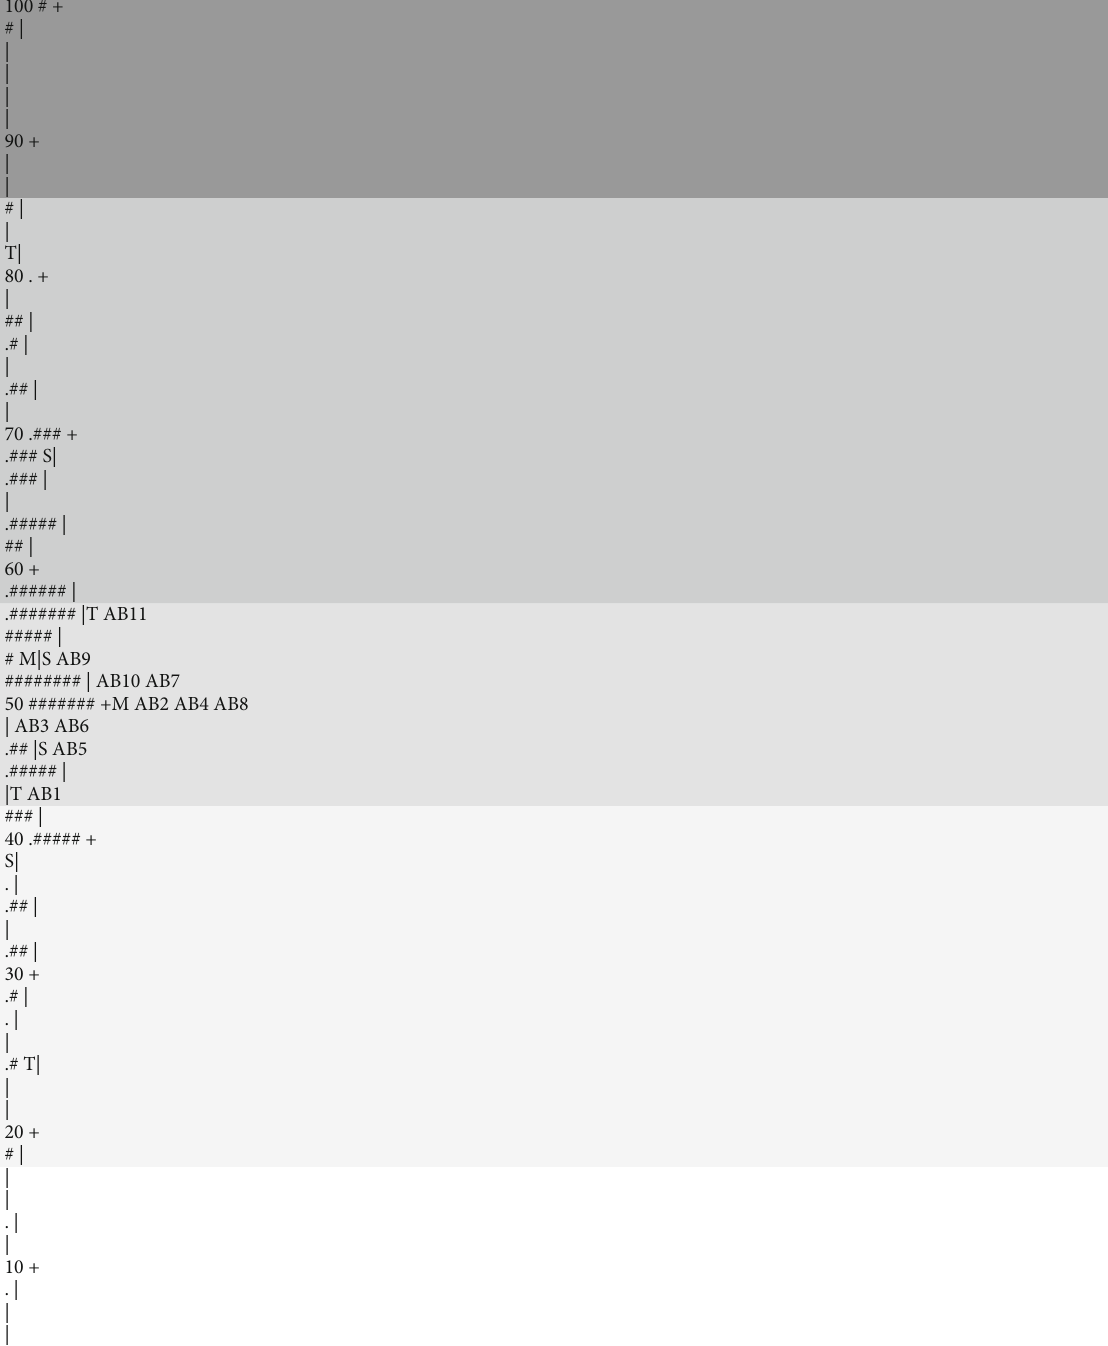
Figure 2: Person-item map. Note: each “ # ” is 2, each “ . ” is